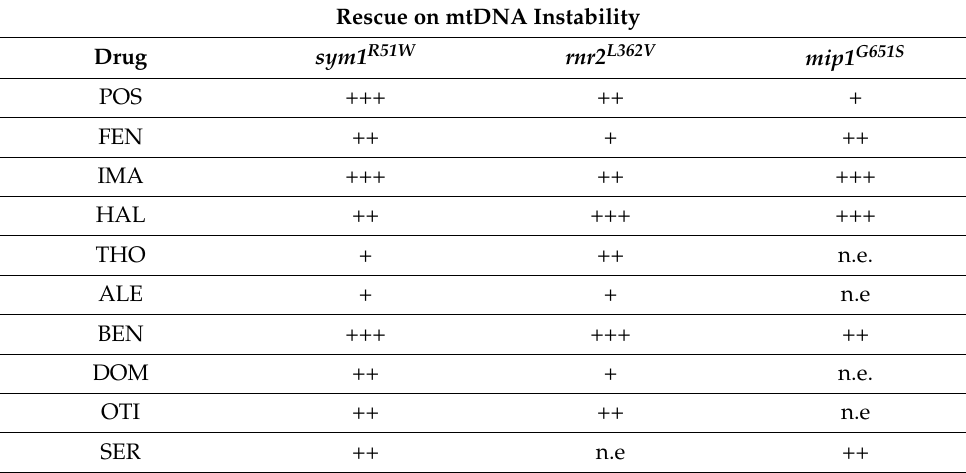
Table 2. Effects of the molecules on the mtDNA instability of sym1 R51W , rnr2 L362V and mip1 G651S mutant strains measured as a reduction of petite frequency. +++ strong effect (greater than 50% reduc- tion); ++ medium effect (reduction between 50% and 25%); + mild effect (less than 25% reduction). The evaluation of the molecule’s efficacy was made on the basis of the results obtained at the most effective concentration identified for each mutant strain. n.e. = no effect.